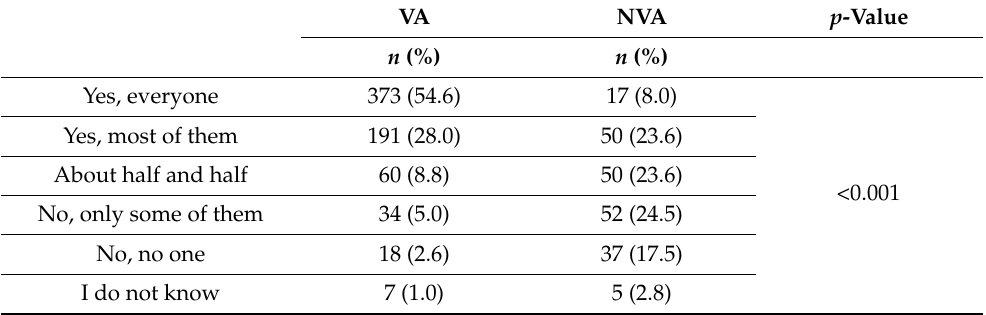
Table 5. Are your relatives (family and friends) vaccinated against COVID-19? Responses broken down by vaccinated (VA, n = 683) and unvaccinated (NVA, n = 212) against COVID-19. VA NVA p -Value n (%) n (%) Yes, everyone 373 (54.6) 17 (8.0) <0.001Yes, most of them 191 (28.0) 50 (23.6) About half and half 60 (8.8) 50 (23.6) No, only some of them 34 (5.0) 52 (24.5) No, no one 18 (2.6) 37 (17.5) I do not know 7 (1.0) 5